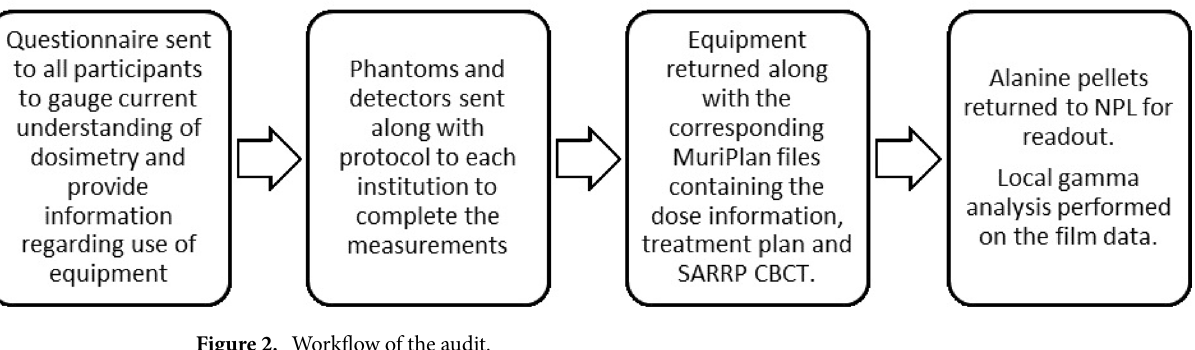
Figure 2. Workflow of the